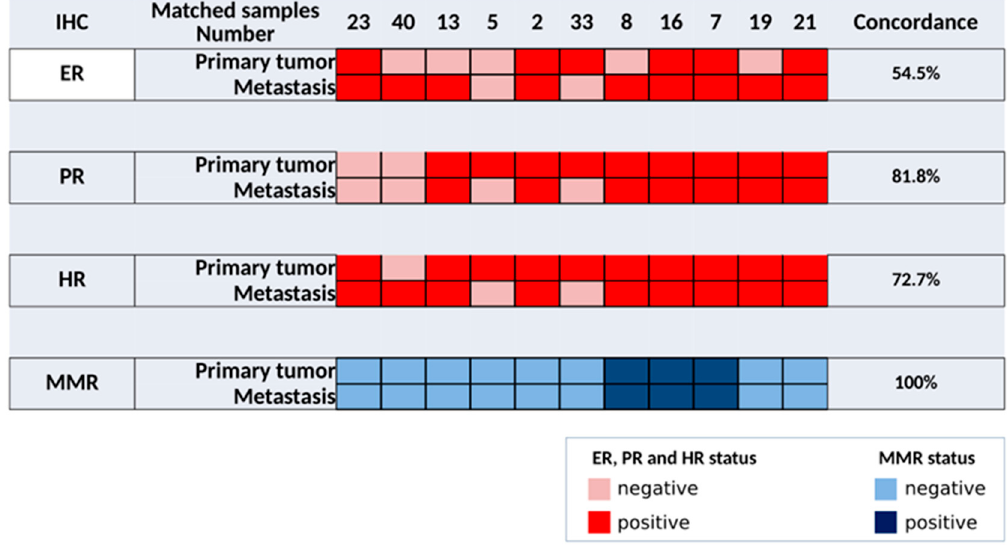
Figure 2. Matched primary and mEC show a high concordance level for HR and MMR. Hormone receptor expression was considered positive if ≥ 10% of cells were positive. Red: positive immunohistochemistry or amplification; dark blue: MSI. IHC: immunohistochemistry; ER, estrogen receptor; PR, progesterone receptor; HR: expression of at least one hormone receptor; MMR, mismatch repair proteins.